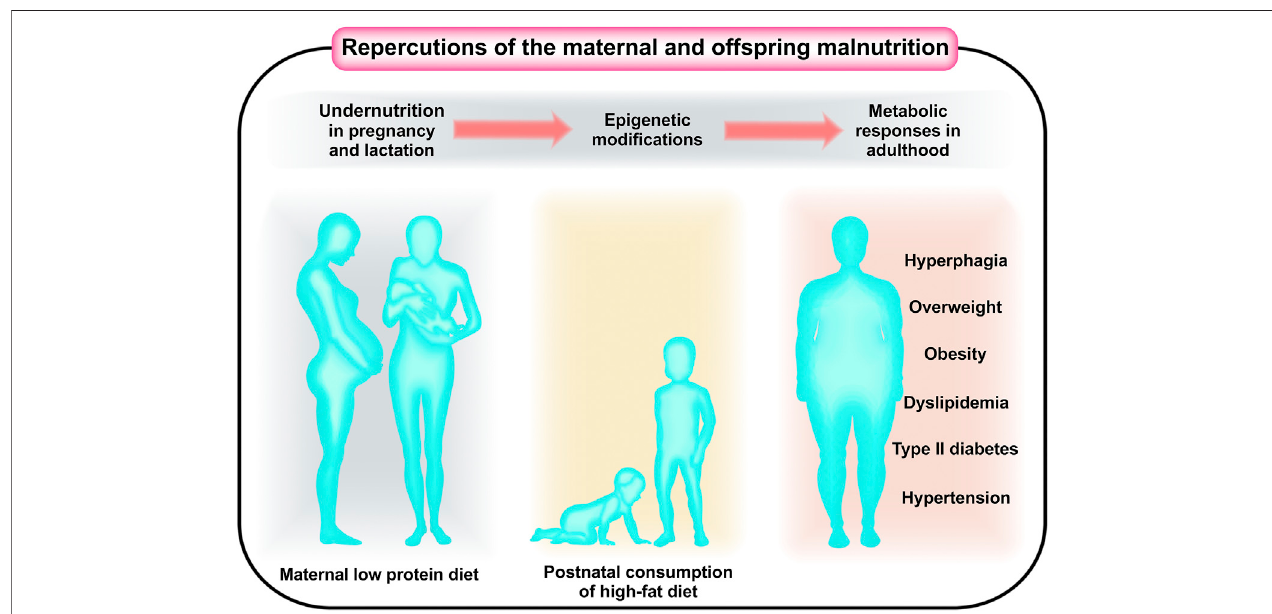
FIGURE 2 | Graphic summary of the repercussions of the postnatal consumption of high-fat diets in individuals subjected to protein restriction during pregnancy and